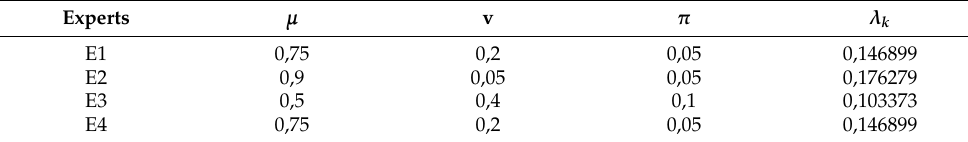
Table 6. Importance of experts